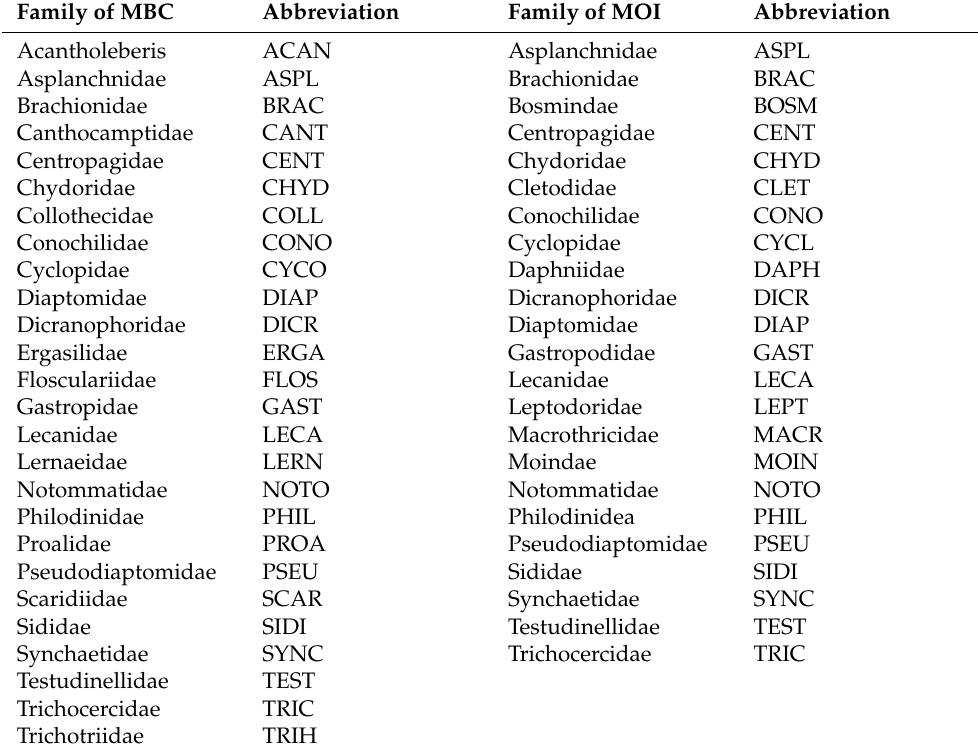
Table A2. The Family of MBC and MOI and their abbreviations.